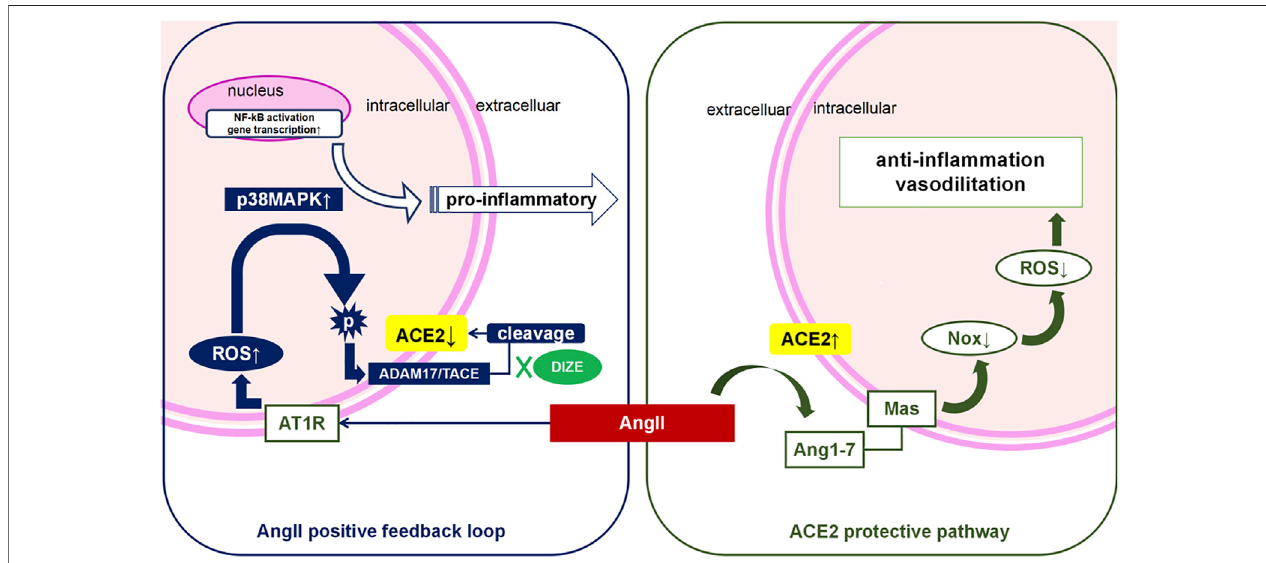
FIGURE 10 | AngII positive feedback loop and ACE2 protective pathway during lung IR injury. During lung IR injury, hypoxia injury triggers Angiotensin II (AngII) secretion from epithelial, endothelial and pulmonary smooth muscle cells, which is worsened by oxidative stress during the reperfusion period ( “ the double whammy ” ). Activation of the AngII-AT 1 R pathway further triggers the reactive oxygen species (ROS) cascade. Meanwhile, there is a homeostatic mechanism that causes excessive AngII to be degragated via ACE2 on the cell membrane, which counterbalances the function of AngII. However, persistent high level of AngII, overload oxidative stress,orotherpro-in fl ammatoryfactorscouldallactivatephosphorylationofADAM17,andphospho-ADAM17cleavestheextracellularfunctionaldomainofACE2,thus deactivating ACE2. The “ positiveAngIIfeedback loop ” resultsinacute orsub-acute lungreperfusioninjury.We havedemonstratedthatDIZEpretreatmentisassociated with lower levels of ADAM17, and that DIZE could suppress the phosphorylation of ADAM17, thus inhibiting ADAM17-mediated ACE2 shedding. Protection of endogenous ACE2 enzyme function during lung IR injury is associated with the reduction of both oxidative stress and nitrosative stress, and decreased in fl ammatory biomarkers, leading to signi fi cant improvement of respiratory function and lung